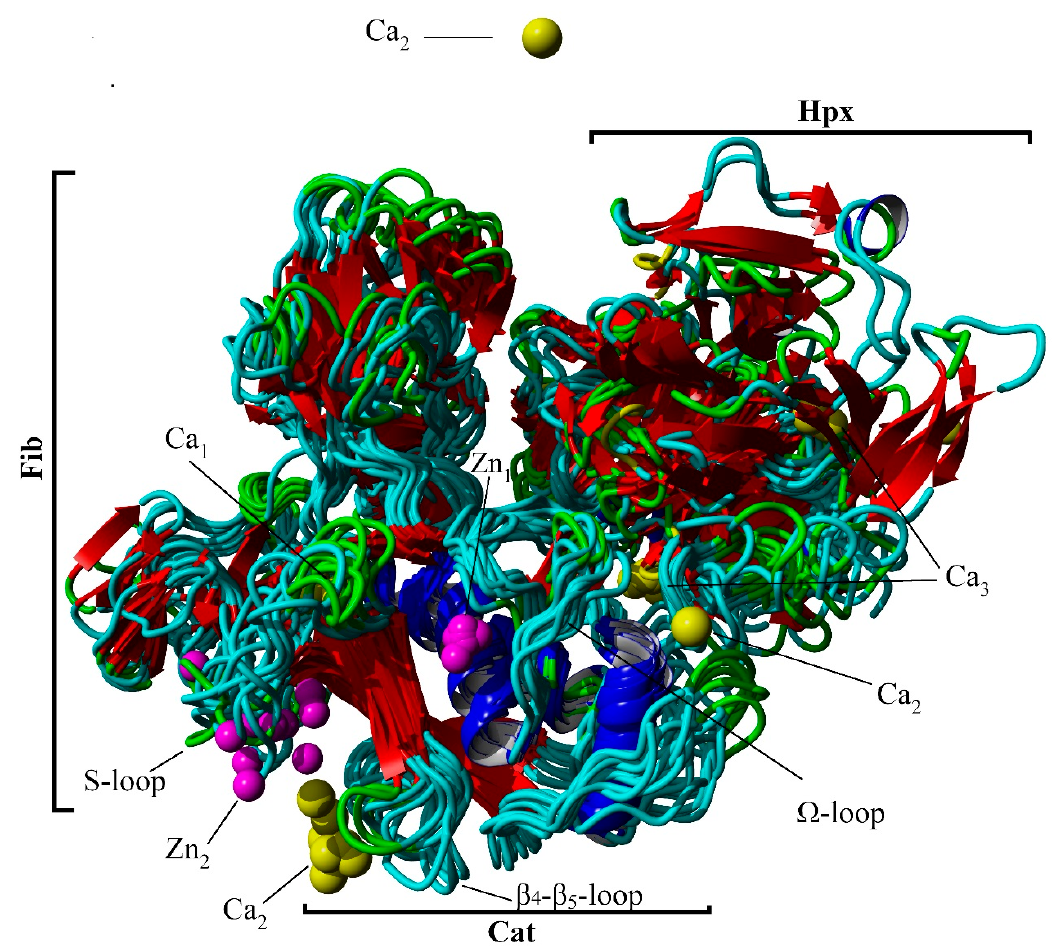
Figure 4. C α -trace overlay of 10 cluster centroid structures from the cluster analysis of dPC1 and dPC2. Secondary structural motifs and ions are shown (blue, α -helix; red, β -sheet; green, β -turn / bend; aqua, coil; pink, Zn 2 + ; and yellow, Ca 2 + ). Table 3. Average RMSF of the associated divalent cations to the C α -trace of MMP-2 a .